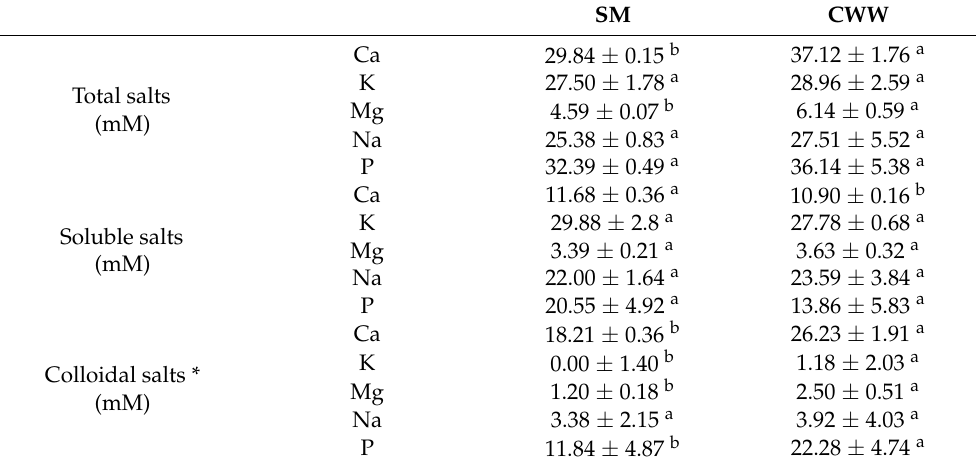
Table 3. Salt contents of skim milk and concentrated white wastewater used for cheese-making: distribution between serum and colloidal phases.